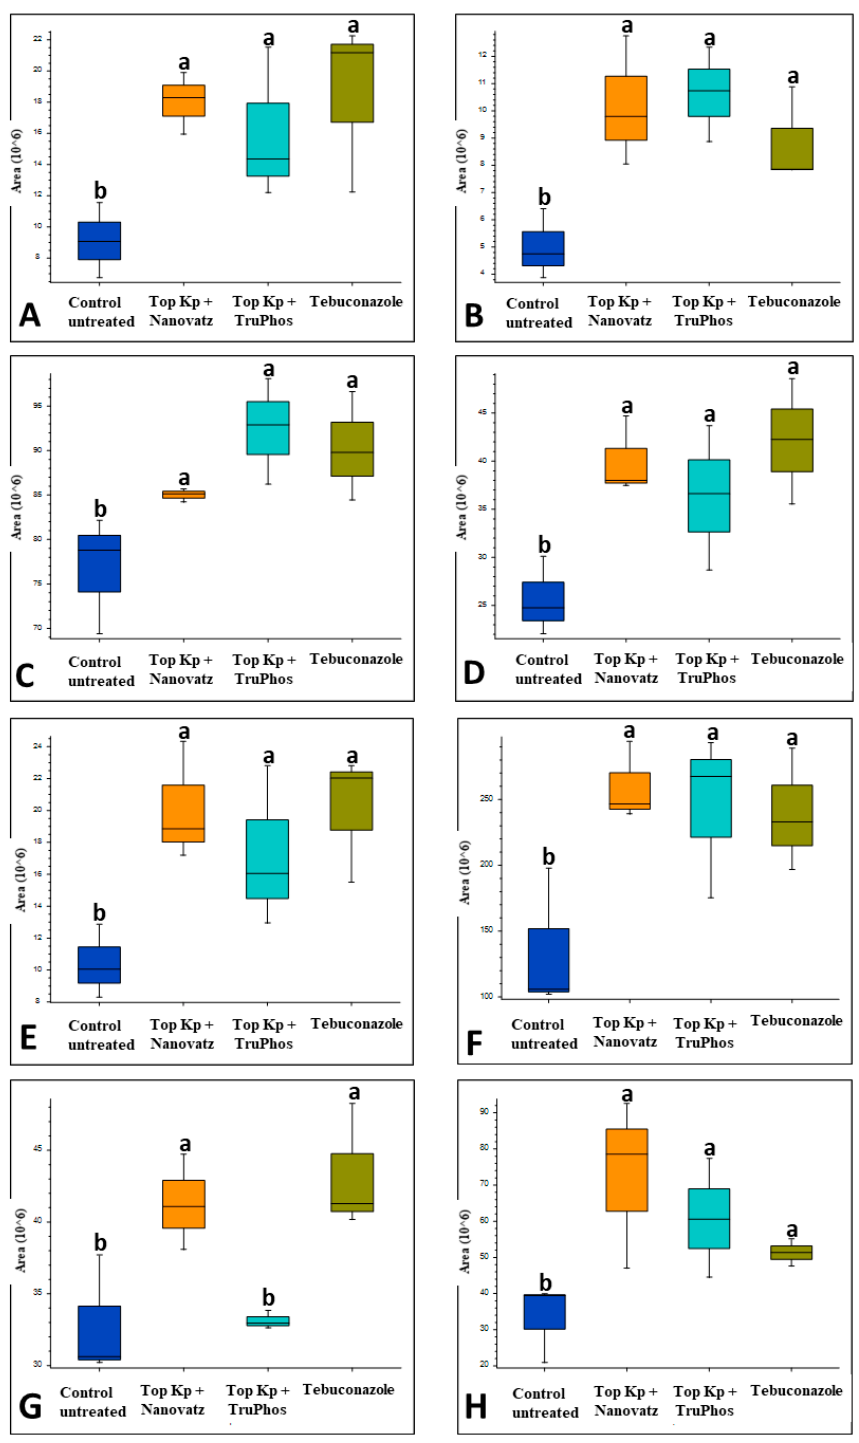
Figure 2. Relative amounts (peak area) of metabolites that were up-produced in grape skins of cv. Riesling vines treated with five foliar spays (starting at April 14 until June 3) of the fungicide Folicur (tebuconazole) 0.02%, or the fertilizers Top KP+ 1% plus Nanovatz 0.1%, Top KP+ 1% plus TruPhos 0.25%, compared to untreated control vines. Analysis was conducted using LC–MS/MS. ( A ) the peptide Leu-Arg, ( B ) the peptide dihydroxy-phenylalanine, ( C ) the peptide Boc-Ser-OH, ( D ) the peptide Boc-Gln-OH, ( E ) the peptide L-gamma-Glutamyl-L-leucine, ( F ) Pheophorbide A, ( G ) Tuliposide B, ( H ) Nocardicin E. Different letters represent significant differences ( p < 0.05, Tukey-Kramer HSD test).